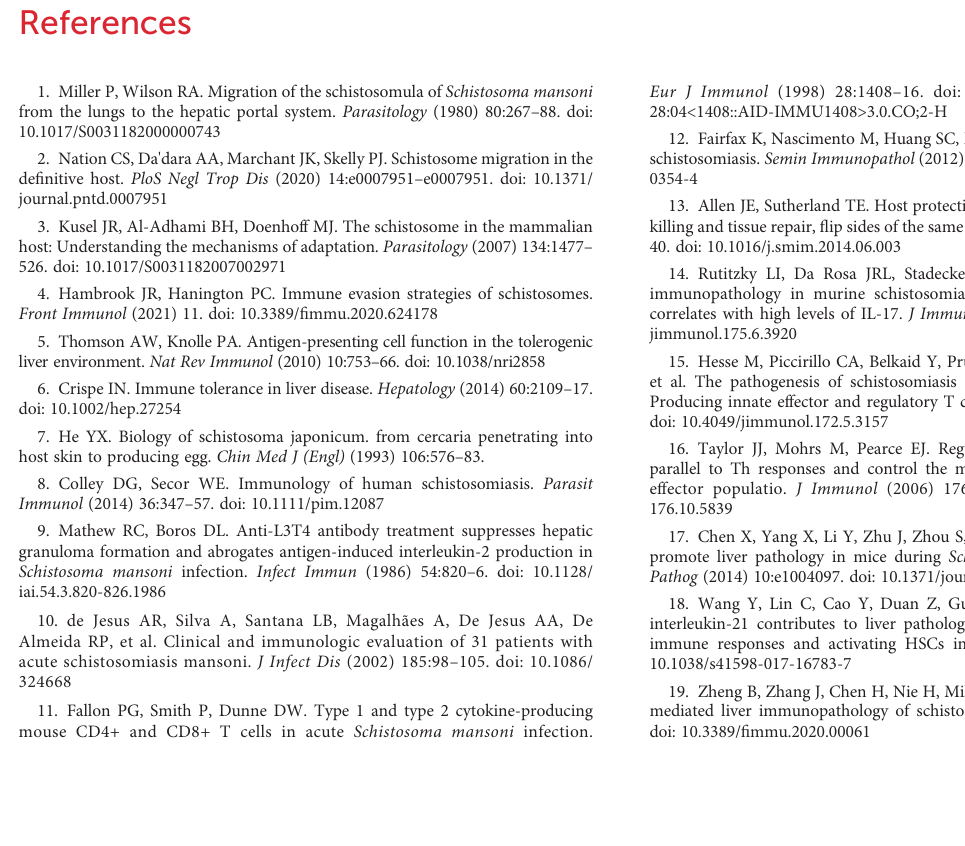
List of primers used for analyzing the expressions of miRNA targets by